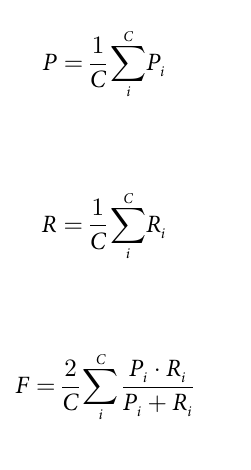
Table 7. The best ML learner for each combination method and its average classification performance (using Accuracy metric). PCA-ML FA-ML FastICA-ML NCA-ML MRMR-ML CHI2-ML FL-ML